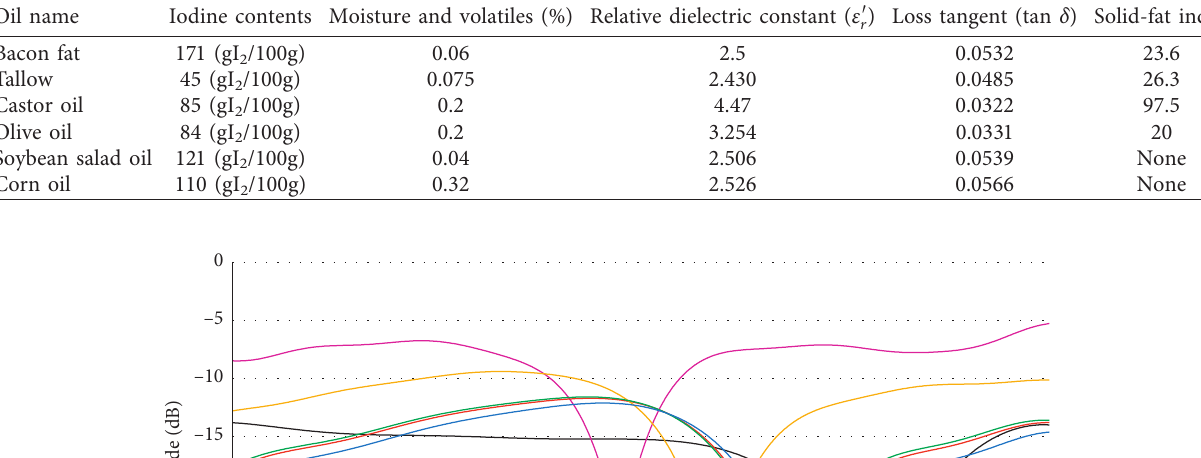
Table 2: Chemical and dielectric properties of some commercial oils [34–36].